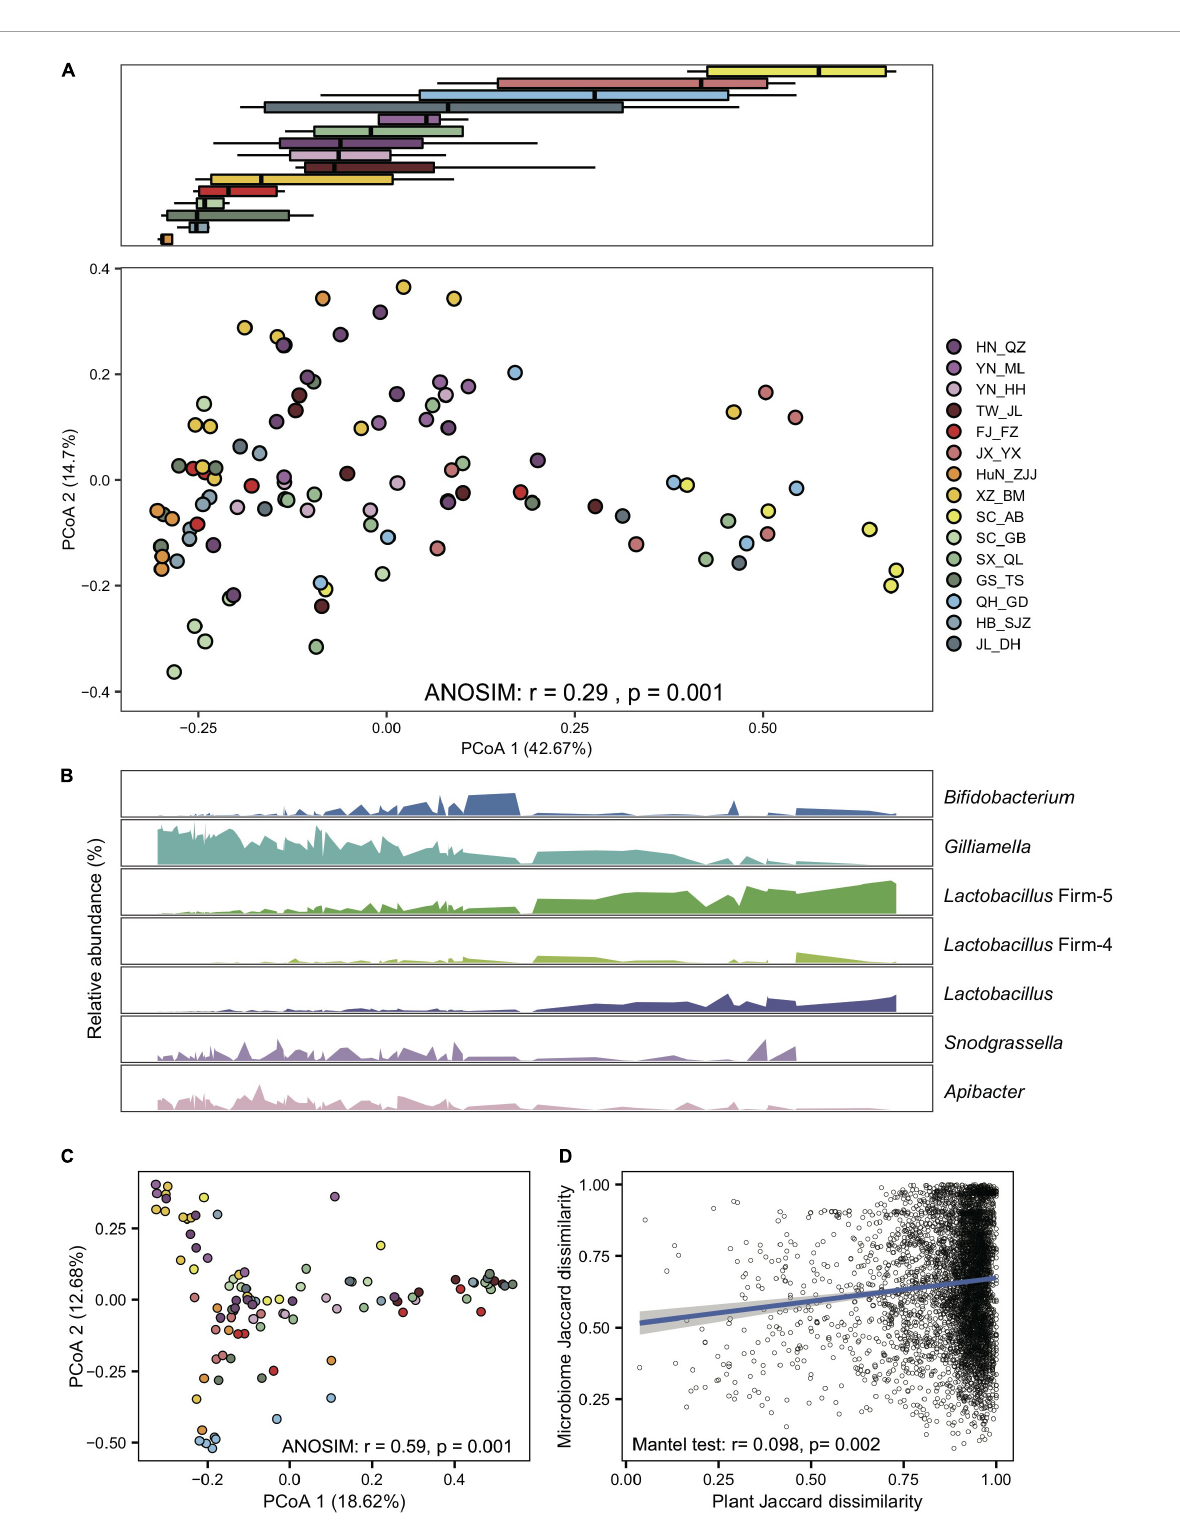
FIGURE2 Gilliamella and Lactobacillus Firm-5 showed antagonistic trends in compositional turnover of honeybee gut microbiomes. (A) Overall variation of the gut microbial community at the phylotype level, revealed by Bray–Curtis dissimilarity PCoA (bottom panel). Boxplots (top panel) indicate the distribution of each population along the first principal coordinate axis (PCoA1). Boxplot center values represent the median and error bars represent the SD. Colors correspond to the population origin of the gut samples. (B) Relative abundances of core bacterial phylotypes along PCoA1. (C) The pollen composition at the family level varied in gut metagenomes from populations of A. cerana . (D) The Jaccard distances of the gut bacterial phylotype and the pollen composition at the family level were significantly